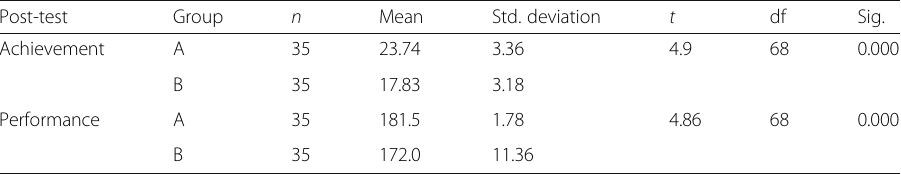
Table 4 Results of descriptive statistics and independent samples t test Post-test Group